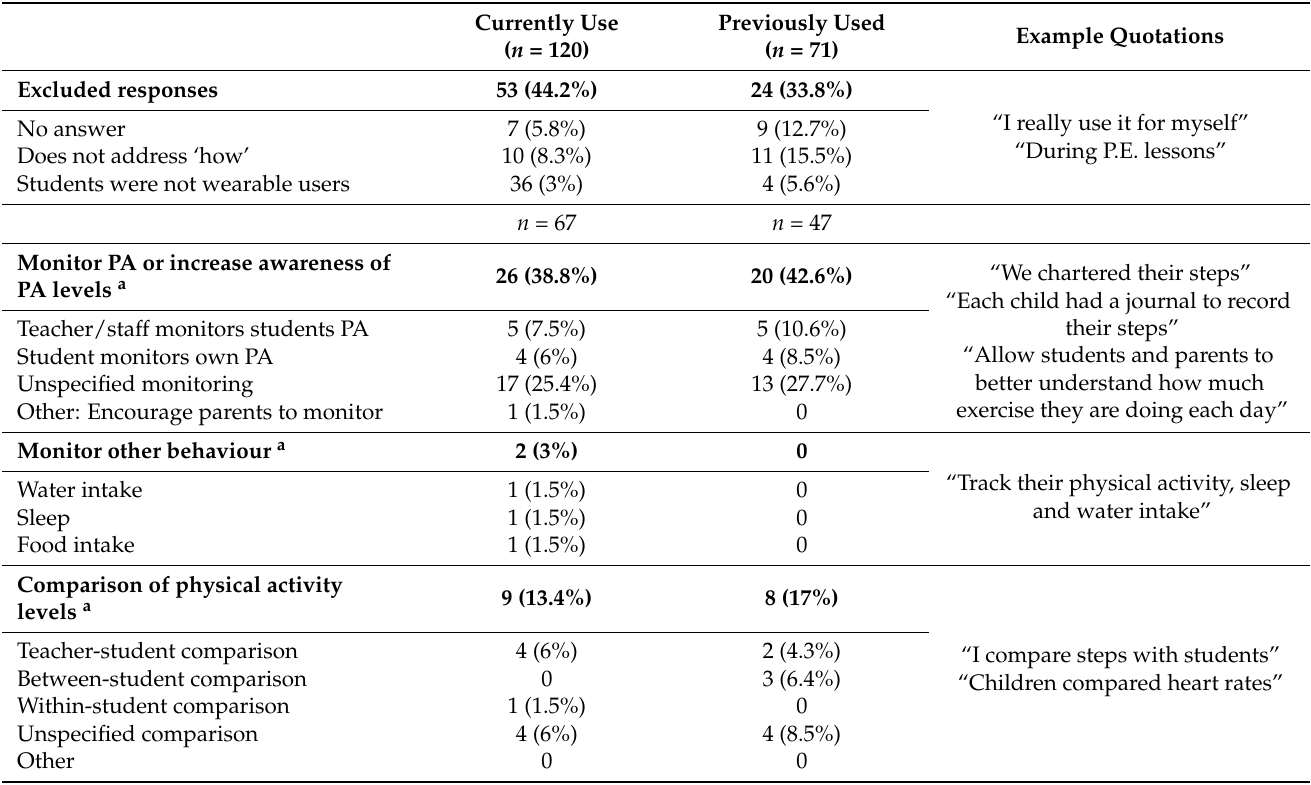
Table 3. How school staff implement the use of wearables in schools, n